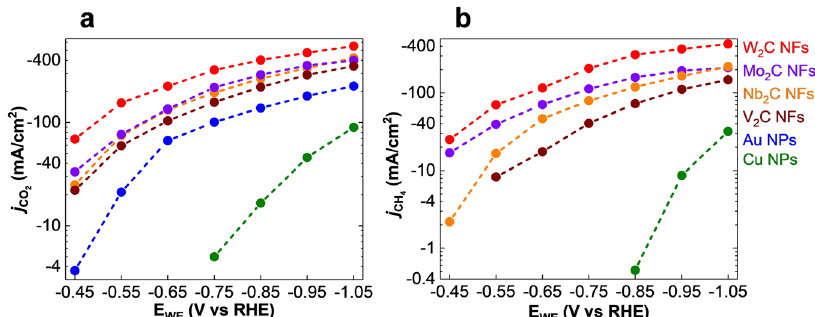
Fig. 1 Electrocatalytic performance of TMCs i.e., W 2 C, Mo 2 C, Nb 2 C, V 2 C NFs in the two-compartment three-electrode electrochemical cell using CO 2 saturated KOH:CC (3 M:2 M) electrolyte. a CO 2 reduction reaction current densities ( j CO2 ) of TMCs compared to Au and Cu NPs at different cathodic potentials (E WE ) under identical experimental condition. b CH 4 formation current densities ( j CH4 ) of TMCs compared to Cu NPs at different potentials (E WE ) under identical experimental